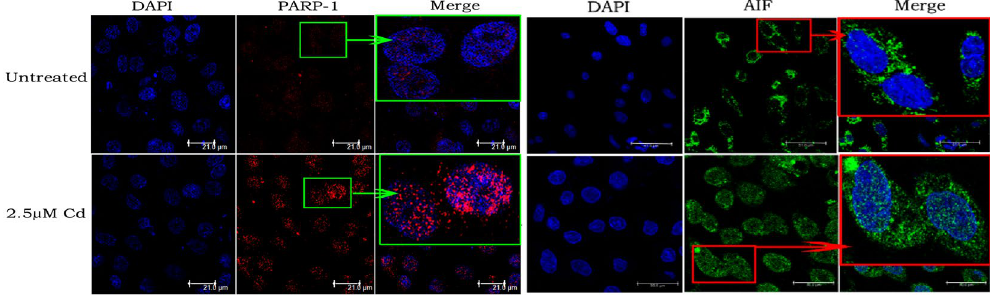
Figure 3. PARP-1 accumulation and the nuclear translocation of AIF in primary rPT cells, as detected by immunofluorescence. Primary rPT cells were treated with or without 2.5 μ M Cd for 12 h and were stained to visualize PARP-1 and AIF Protein. Nuclear accumulation of active PARP-1 protein (Red) and AIF (green) translocation into the nucleus were obvious.